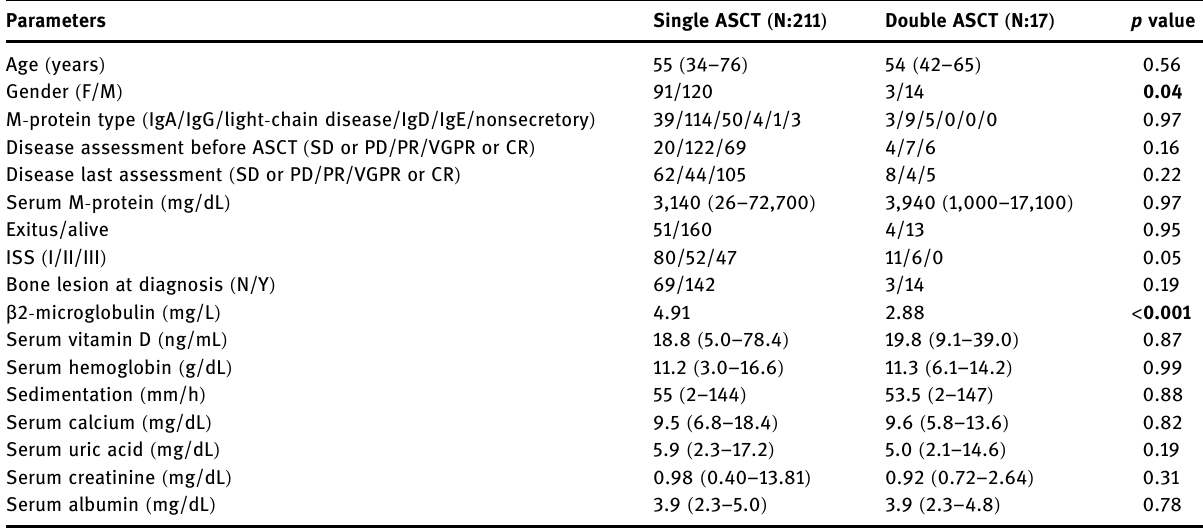
Table 1: The baseline characteristics of the patients in the single and double ASCT groups Parameters